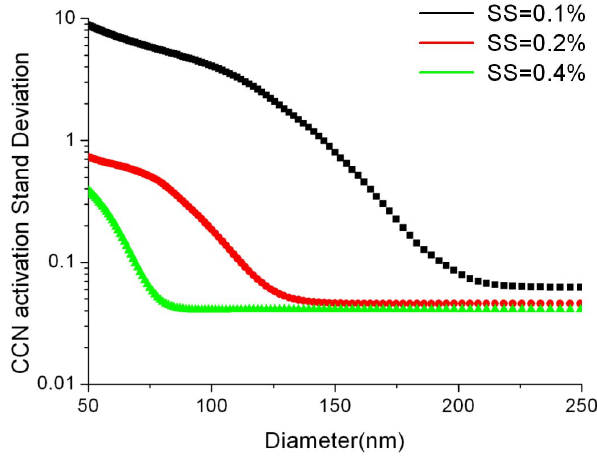
Fig. 4. The size-resolved CCN activation of aerosol particles under Fig.4 The size ‐ resolved CCN activation of aerosol particles under SS of 0.1%, 0.2% and 3 SS of 0.1%, 0.2% and 0.4% respectively. 0.4% respectively 4